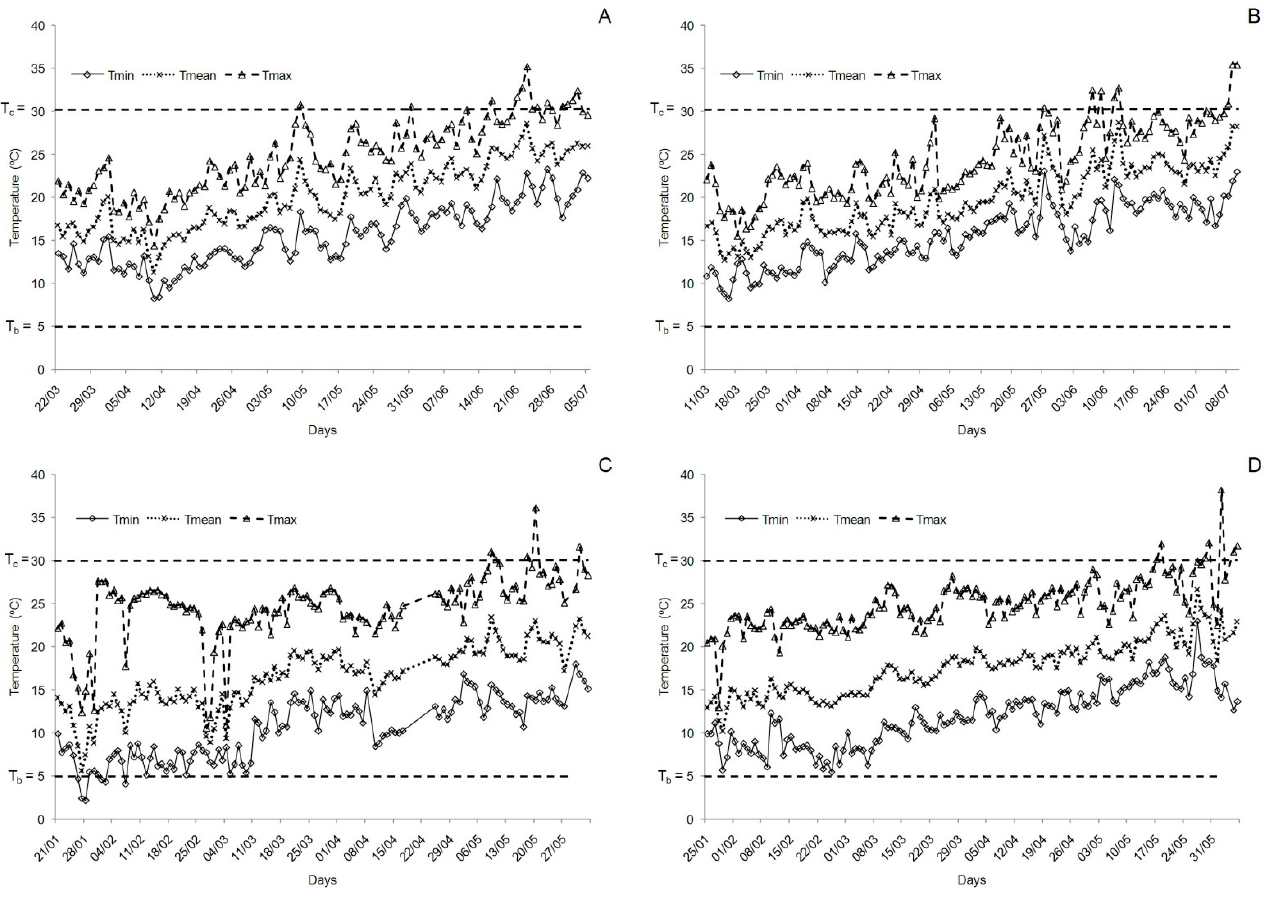
Figure 2. Minimum, mean and maximum daily temperatures during the coolest season (2005) and the warmest season (2006) in the open field ( A and B , respectively) and inside the plastic greenhouse ( C and D , respectively).